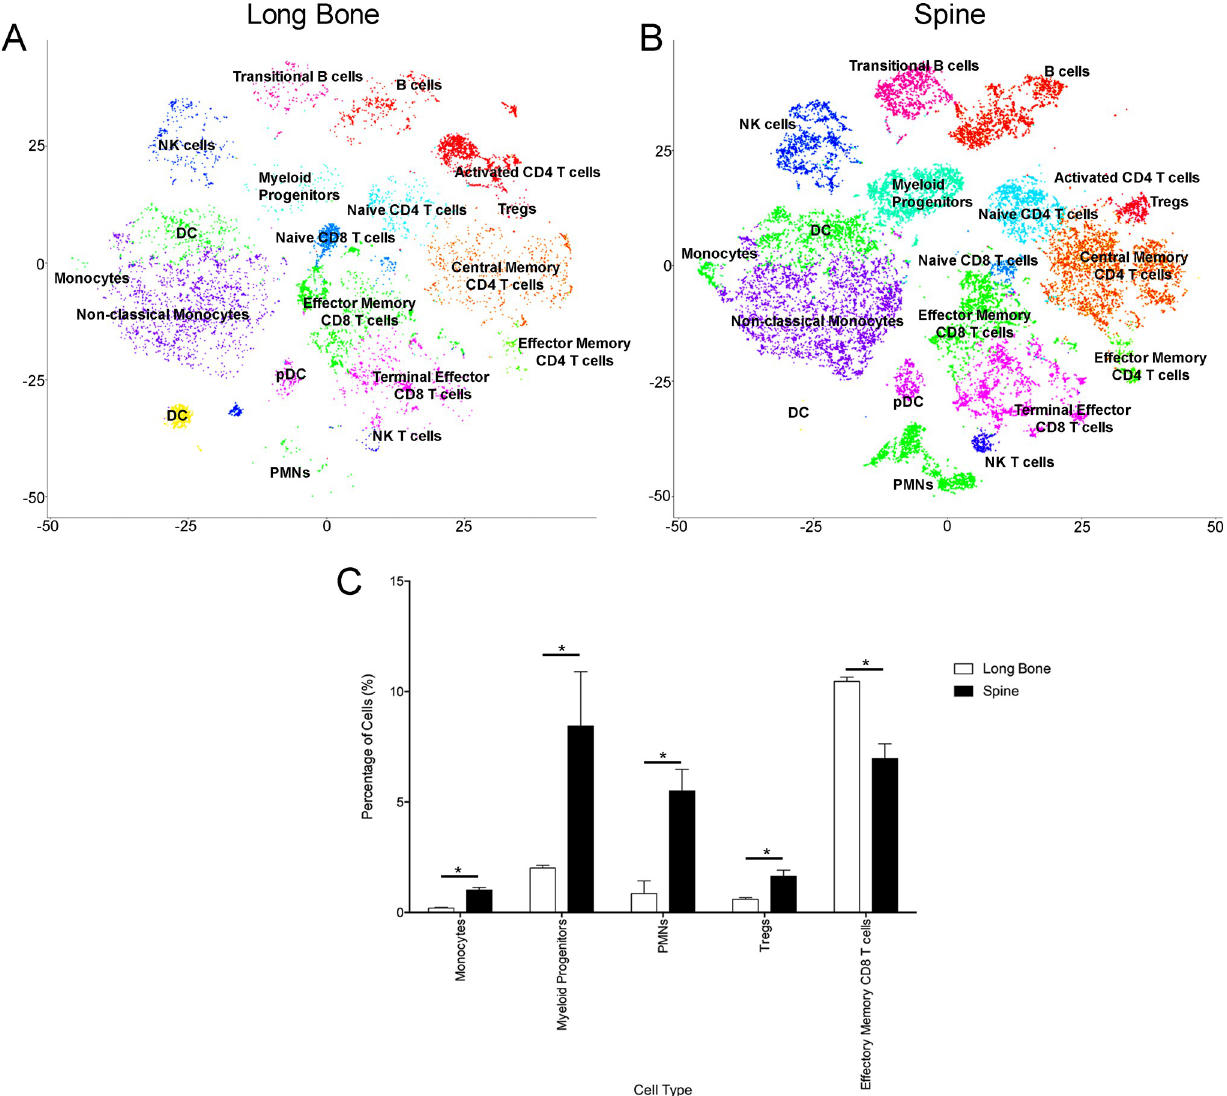
Fig 2. Characterization of the immune cell landscapes of human long bone and vertebral body bone marrow using CyTOF. Representative t-SNE plots show PhenoGraph clusters for ( A ) long bone and ( B ) spinal bone marrow. ( C ) Frequencies of statistically different immune cell populations between the two bone marrow samples. All cell types listed were statistically significant; p < 0.05. n = 4, percent of cells (SD, � denotes p < 0.05, �� denotes p <